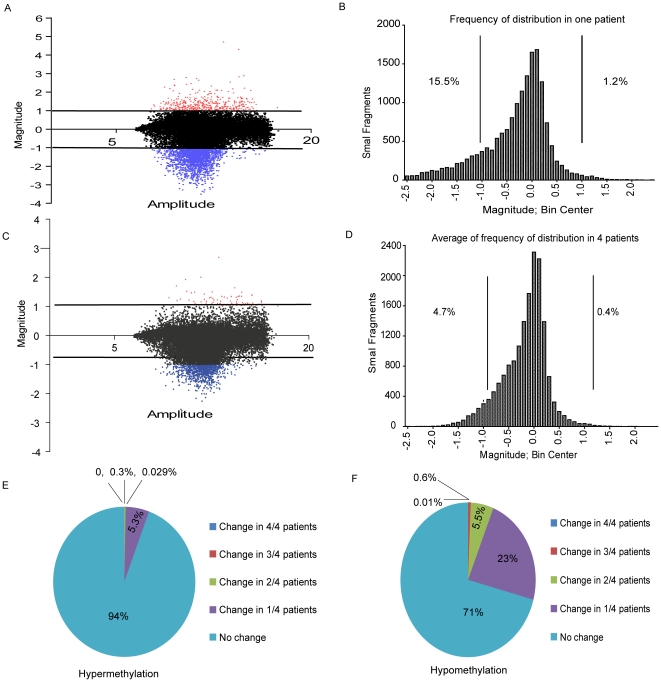
MCAM analysis of secondary resistance.A. Representative plot of A–M MCAM analysis in one patient. The plot shows Amplitude (A) = ½ (log2 R×G), and Magnitude (M) = log2(R/G). The red, black, and blue spots indicate probes hypermethylated, unchanged, and hypomethylated in MDS patients, respectively. B. Frequency of distribution of SmaI fragments in one patient. Values below −1 indicate hypomethylation at relapse, while values above 1 indicate hypermethylation. C. Representative plot of A–M MCAM analysis in 4 patients. We averaged A and M in four patients and performed A–M plot. D. Frequency of distribution of SmaI fragments in 4 patients. We averaged the value of SmaI fragments in four patients and performed analysis of frequency of distribution. E. Pie diagram of hypermethylated genes at relapse. We calculated the percentage of genes that are not hypermethylated, hypermethylated in 1 patient, or commonly hypermethylated in 2, 3, or 4 patients at relapse, respectively. Pie diagram was performed based on the percentage of these genes. F. Pie diagram of hypomethylated genes at relapse. We calculated the percentage of genes that are not hypomethylated, hypomethylated in 1 patient, or commonly hypomethylated in 2, 3, or 4 patients at relapse, respectively. Pie diagram was performed based on the percentage of these genes.